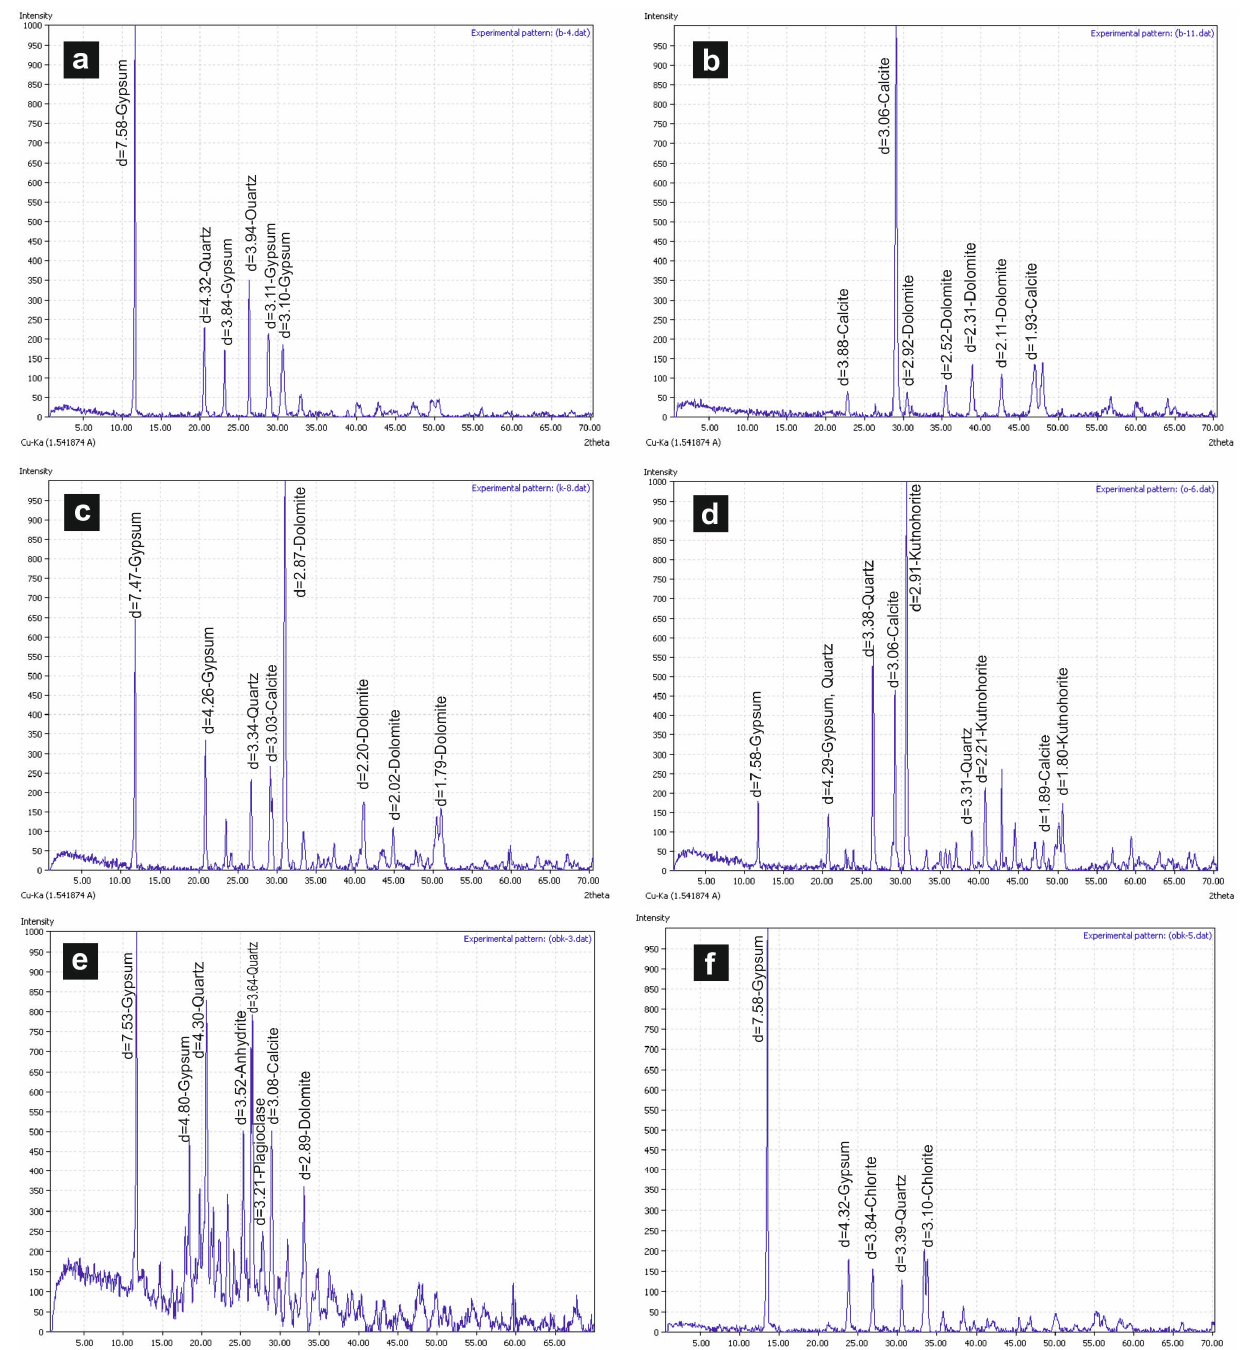
Figure 5. ( a , b ) XRD peaks of B-4 and B-12 samples (Örencik); ( c ) XRD peaks of K-8 sample (Köprüa ğ z ı ); ( d ) XRD peaks of O-6 sample (Örenkale); ( e , f ) XRD peaks of OBK-4 and OBK-15 samples (Gönen).